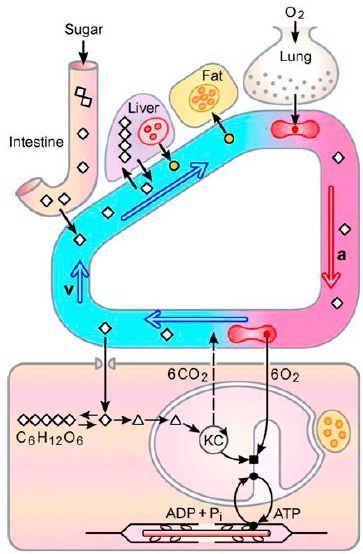
Figure 7. The sugar oxidation cascade provides most of the energy required for flight in hover-feeding hummingbirds and nectar bats. This diagram shows how the sugar oxidation and O 2 transport cascades operate in parallel in hover-feeding hummingbirds and nectar bats. During hovering flight, >90% of whole-body O 2 consumption rates are due to flight muscle mitochondrial respiration. In the O 2 transport cascade, O 2 travels from the external environment through the respiratory and cardiovascular systems and into muscle mitochondria through a series of convective and diffusive processes at rates determined by muscle energy demands. In the fasted state, mitochondrial respiration is fueled by fatty acid oxidation. During repeated hover-feeding, dietary sugars (twin diamond denotes sucrose; single diamonds denote glucose and fructose) are ingested. Sucrose is hydrolyzed; glucose and fructose cross the intestinal epithelium primarily through a paracellular pathway and enter the blood. Most of the ingested sugar is transported into the flight muscles and broken down. The sugar and O 2 transport cascades converge in the mitochondria where carbon compounds derived from dietary sugar (pyramids) are oxidized to provide reducing equivalents for respiration and oxidative phosphorylation. Ingested sugars in excess of energetic needs are converted to glycogen (strings of diamonds) and fat (yellow-filled circles). From